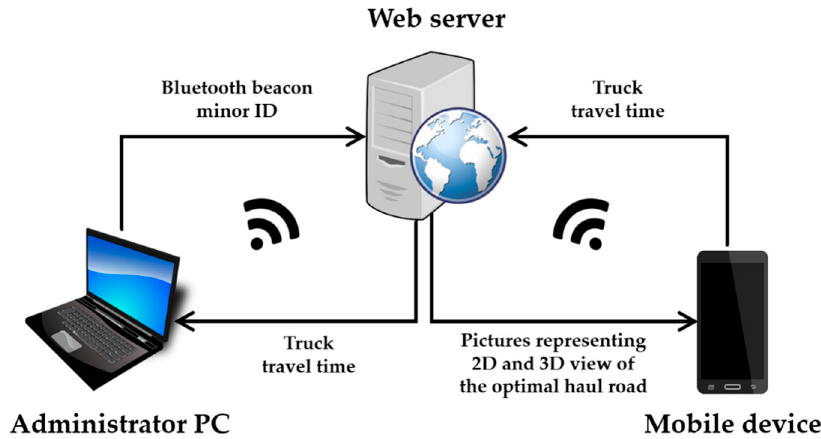
Figure 6. Conceptual view of data exchanges that occur when Bluetooth beacon-based underground navigation system (BBUNS) recognizes the signal of Bluetooth beacon that has minor ID 1.